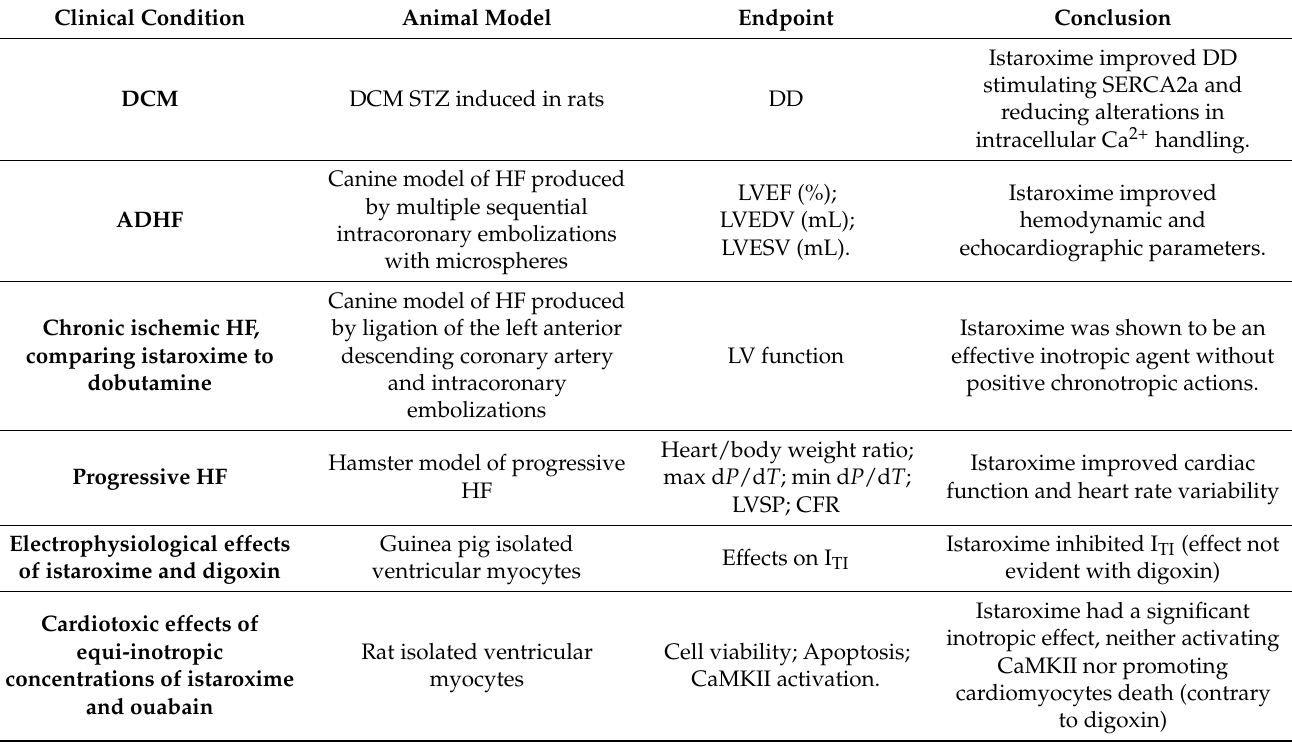
Table 1. Summary of designs and conclusions of preclinical studies investigating